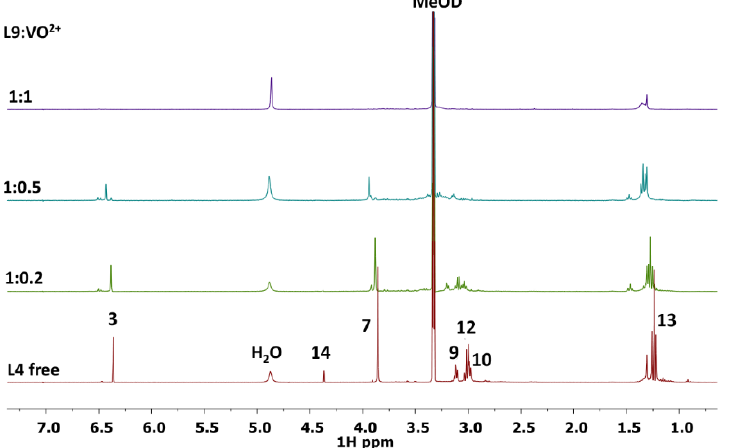
Figure 8. 1D 1 H NMR spectra of L9-V IV O 2+ system in MeOD at different L9:V IV O 2+ ratios.